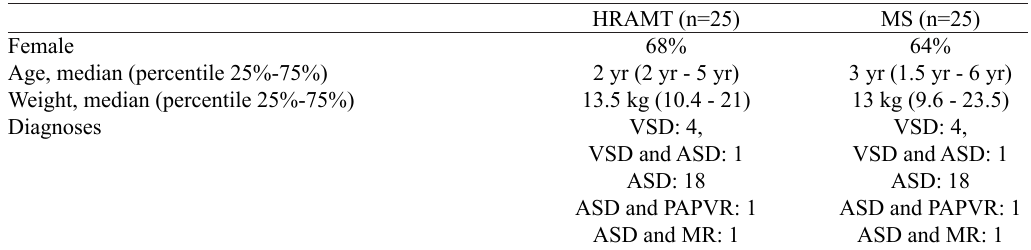
Table 1. Preoperative characteristics of